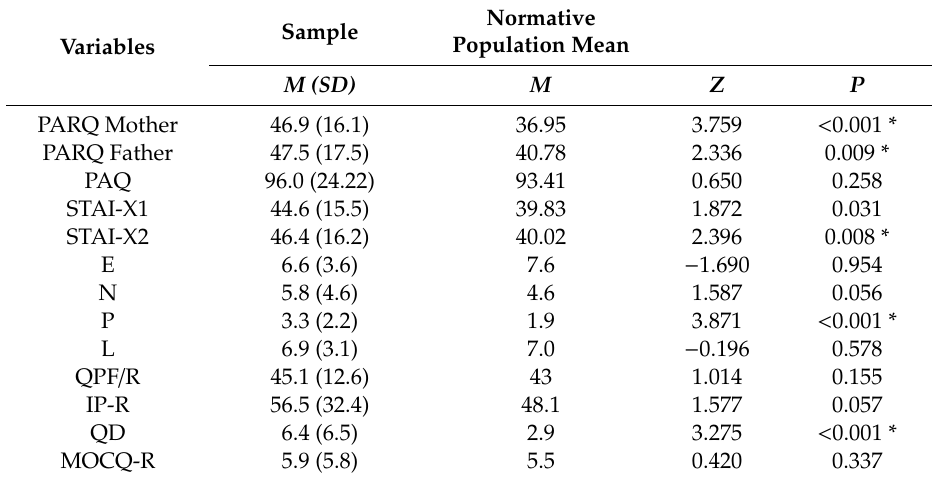
Table 2. One sample z-test results and descriptive statistics of a normative population.